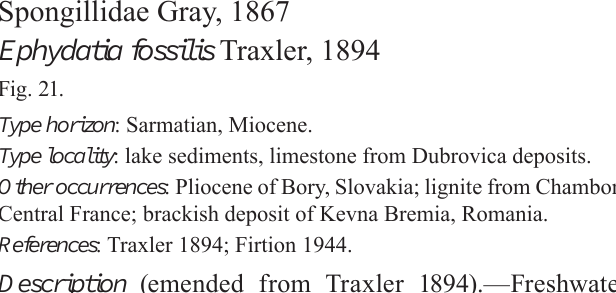
Fig. 21. Type horizon : Sarmatian, Miocene. Type locality : lake sediments, limestone from Dubrovica deposits. Other occurrences : Pliocene of Bory, Slovakia; lignite from Chambon, Central France; brackish deposit of Kevna Bremia, Romania. References : Traxler 1894; Firtion 1944.